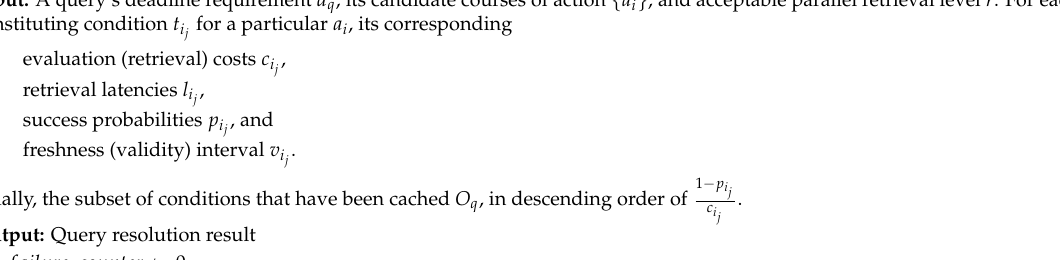
Algorithm 1 Retrieval schedule for dynamic query